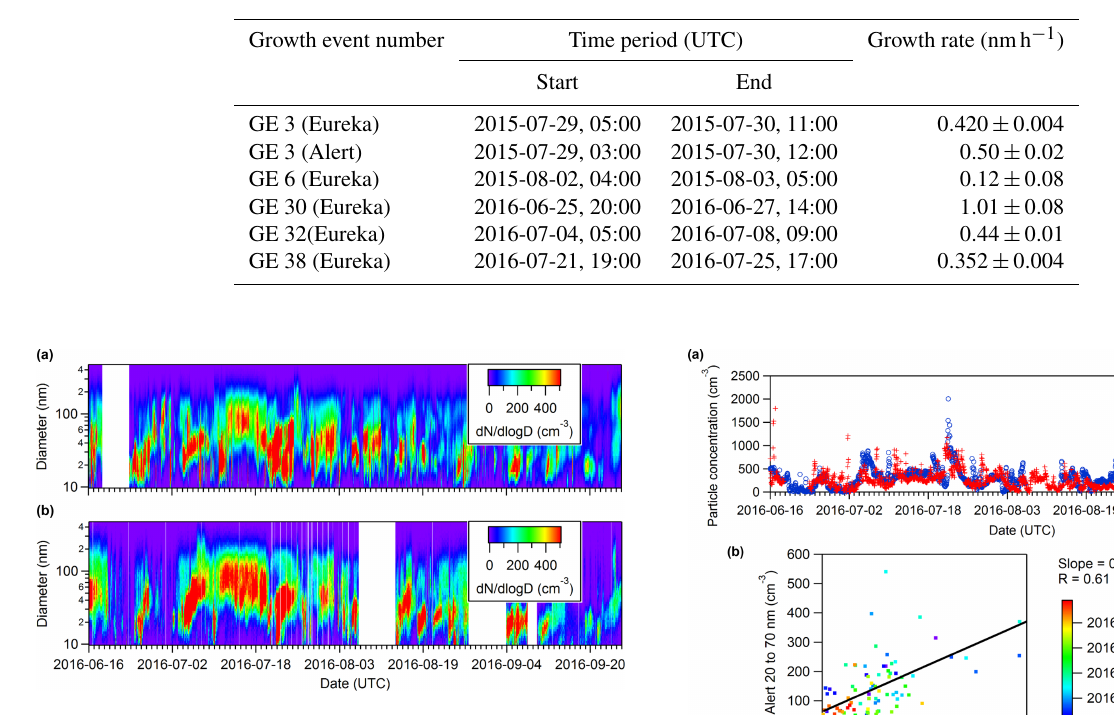
Figure 1. The size-resolved particle concentration measured by SMPS instruments during summer 2016 in Alert (a) and at the PEARL RidgeLab (b) in the Canadian Arctic Archipelago. The sizes are mobility diameters measured by an SMPS, which are equal to the physical diameters under the assumption that the particles were spherical and contained no voids.